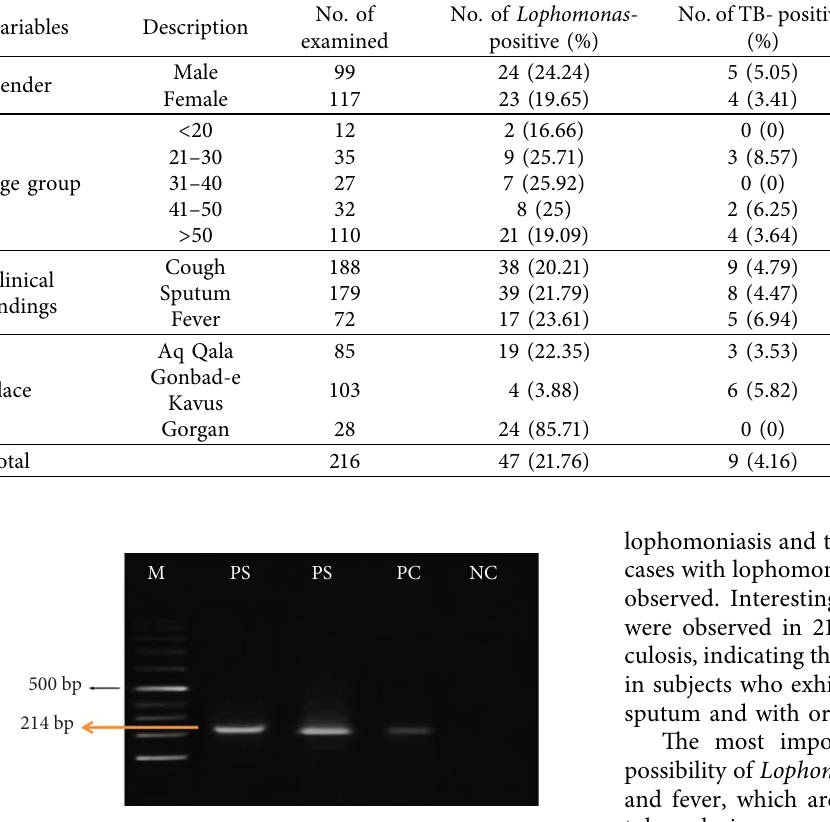
Figure 2: A 214bp band from the PCR products of positive sputum samples infected with Lophomonas spp., in 2% agarose gel elec-